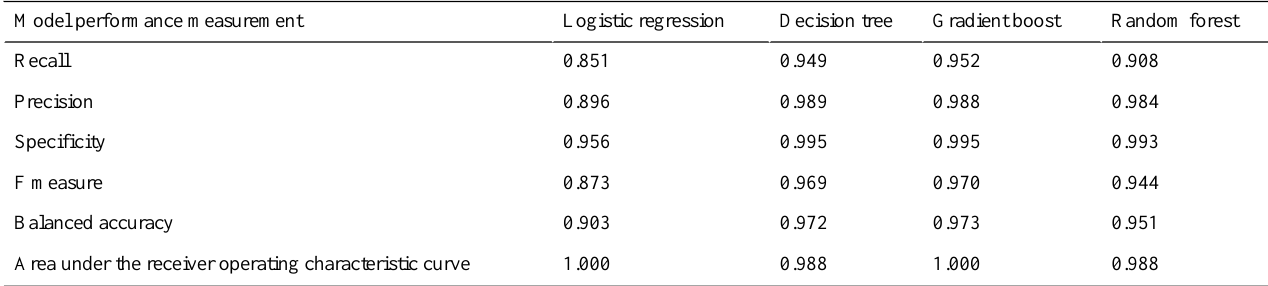
Table 3. Machine learning model performance